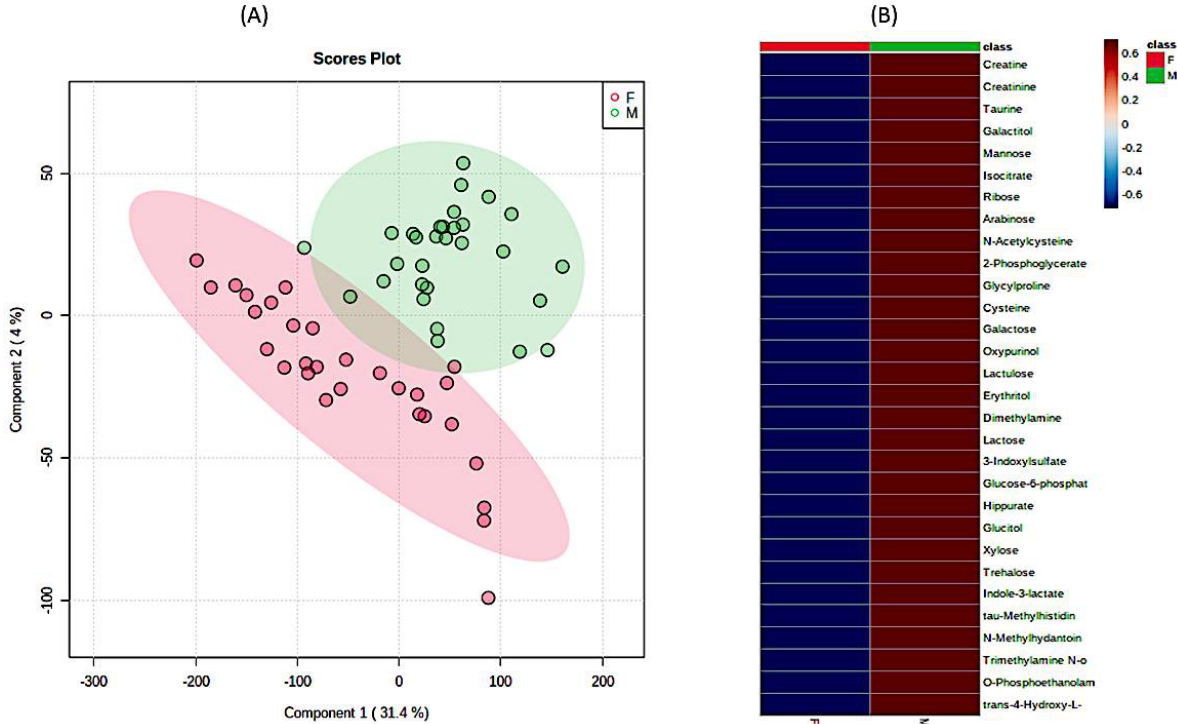
Figure 3. The significant differences in urine 1H-NMR metabolomic profiles between females and males in matched healthy cohorts. ( A ) PLSDA analysis and ( B ) heatmap analysis representing existing differences in the first 30 most important metabolites. (F—females (red), M—males (green)). The most differentiating metabolites were selected by the PLSDA VIP score, where decreasing metabolites had negative values (blue color) and increasing metabolites had positive values (red color).